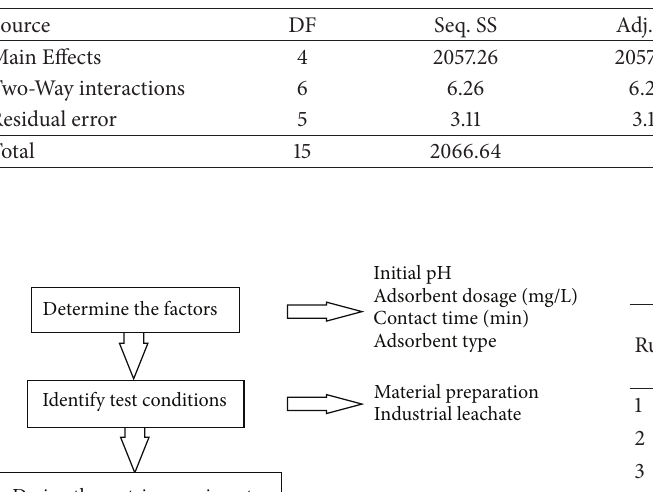
Table 5: Analysis of variance for 𝑅 % (coded units).